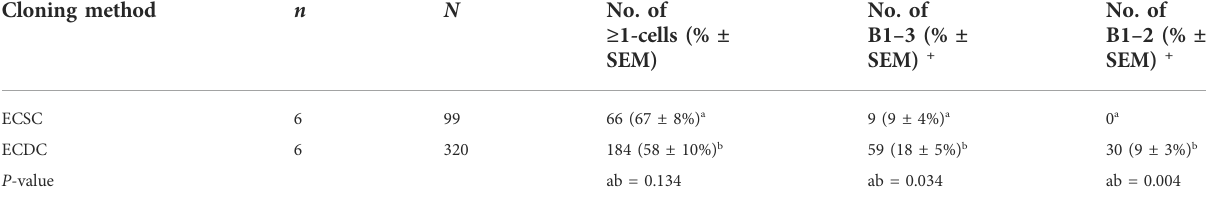
TABLE 1 In vitro development of ECSC vs. ECDC embryos from mitotic ICM donor cells. Cloning method